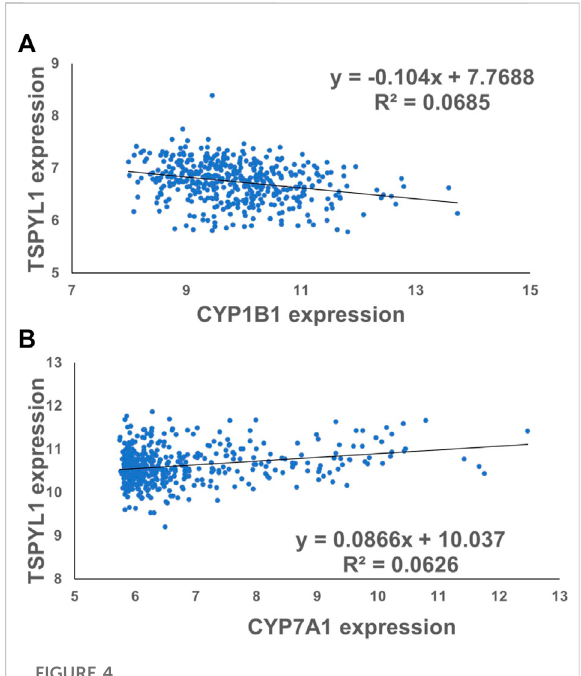
FIGURE 4 TSPYL1 expression associates with CYP1B1 and CYP7A1 expression levels in human liver tissue. (A) The expression correlation coef fi cient for CYP1B1 and TSPYL1 was − 0.26. (r = − 0.26, ****, p = 1.35e-08). (B) The expression correlation coef fi cient for CYP7A1 and TSPYL1 was 0.25. (r = 0.25, ****, p = 5.54e-08). These data were obtained from a previous publication Innocenti et al.